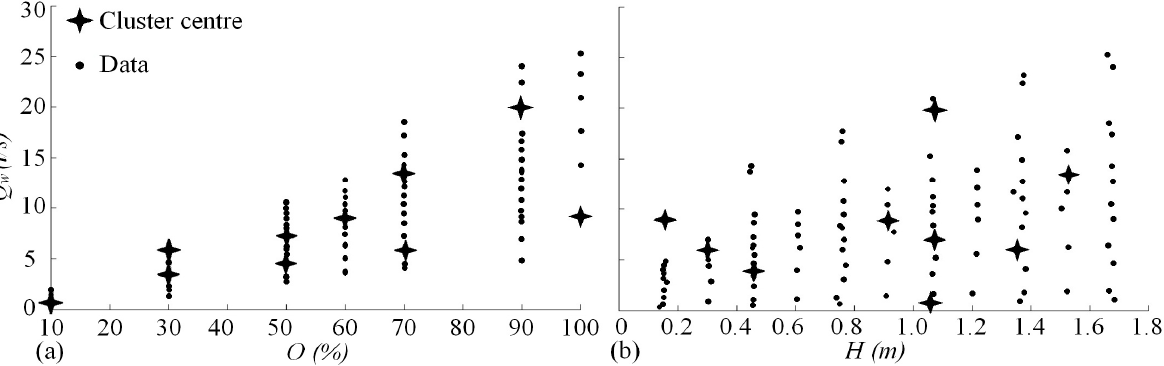
Figure 4. Cluster centres using the centre of gravity method in ( a ) input 2 [gate opening ( O )] and input 4 [water discharge ( Q input 4 ( Q ). w